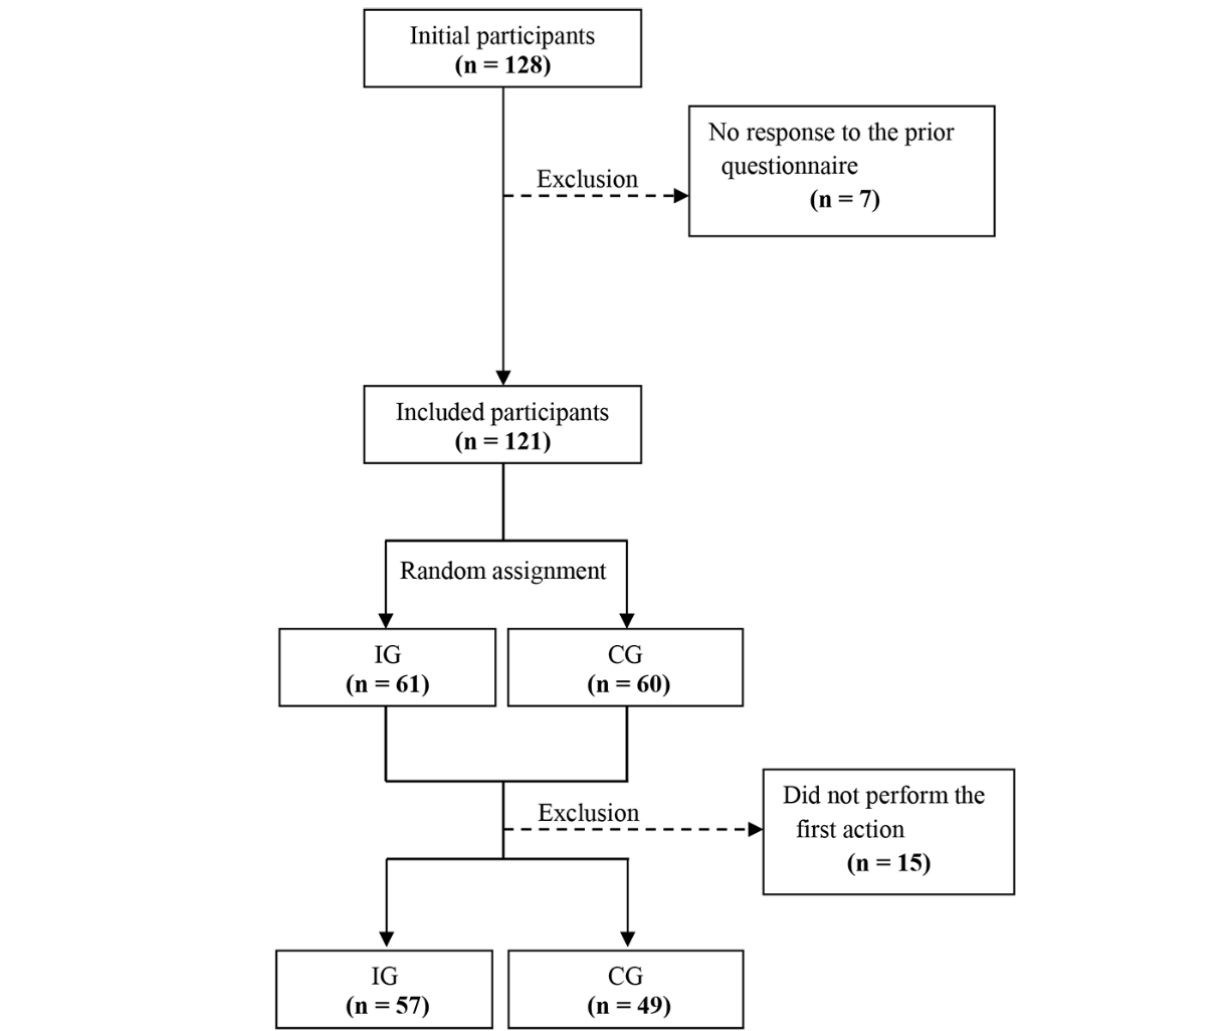
Figure 1. Flow of study participant